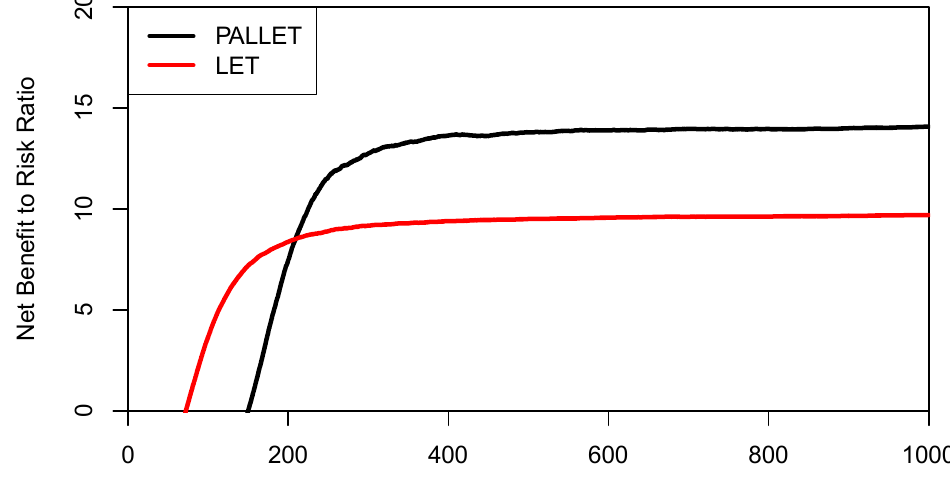
Figure 9. Cost-effectiveness risk-aversion curve (CERAC) of PALLET (palbociclib and letrozole) versus LET (letrozole) in patients with metastatic ER + HER2- breast cancer. CERACs are estimated using the 25% percentile of the NMB distribution for PALLET and the median of the NMB distribution for LET to estimate downside deviation. The two CERACs cross at CHF 209,600 ($US 225,219) per QALY where PALLET becomes preferable.